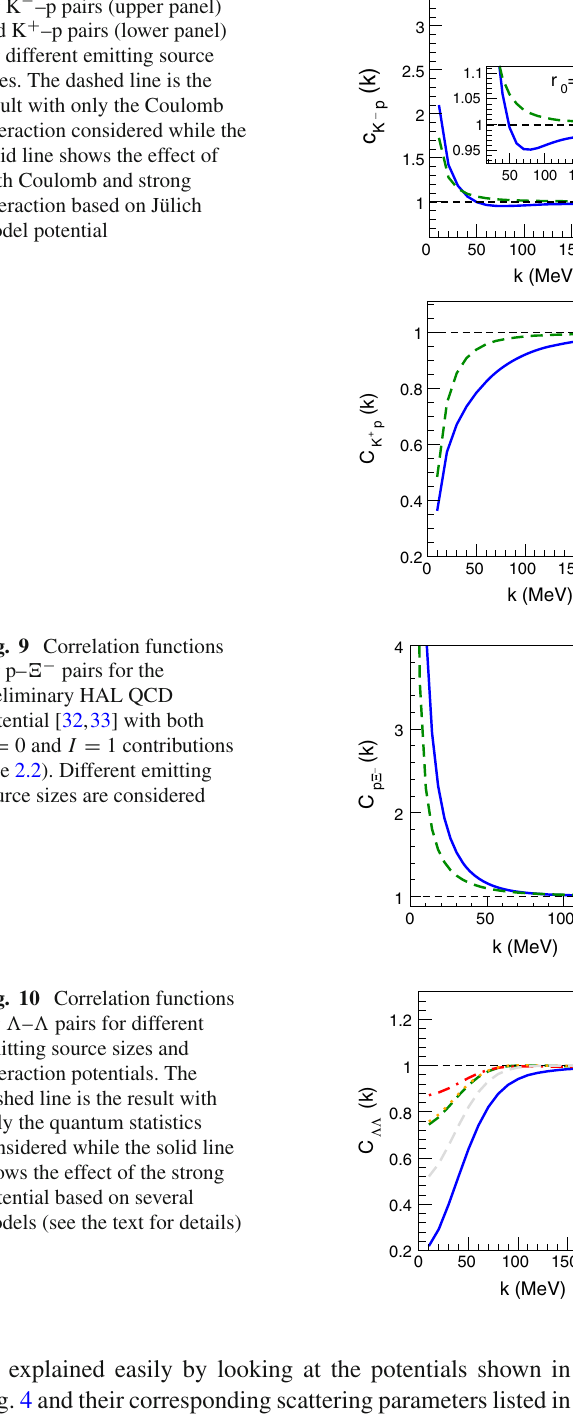
is much weaker due to the presence of a large repulsive core. When making predictions about the correlation function it is important to take into account the expected experimental limitations. In particular the momentum resolution and the residual correlations contributing to the femtoscopic signal can distort the correlation function [77]. To estimate how the p– (cid:3) − and (cid:2) – (cid:2) correlation functions would be affected